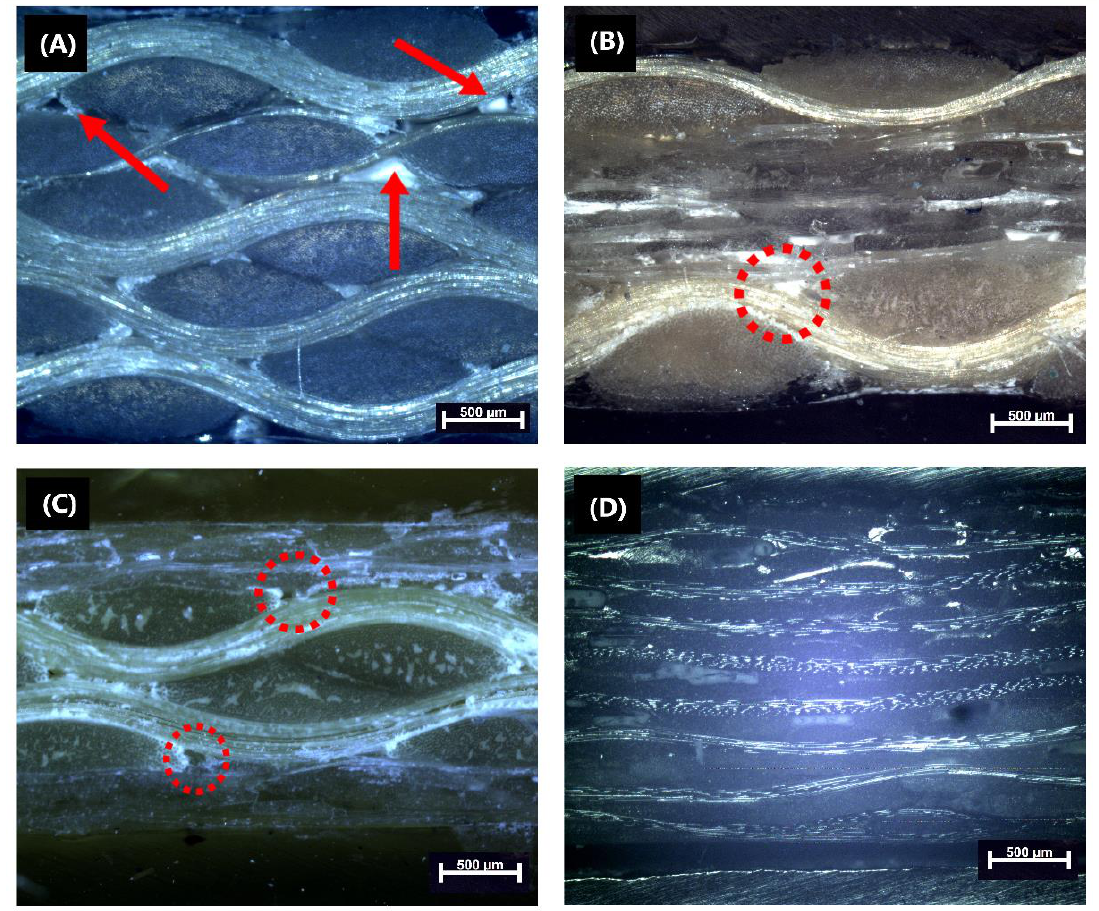
Figure 4. Cross-section micrographs of: ( A ) K 5 ; ( B ) (KG 2 ) S ; ( C ) (G 2 K) S and ( D ) G 8 (50×).